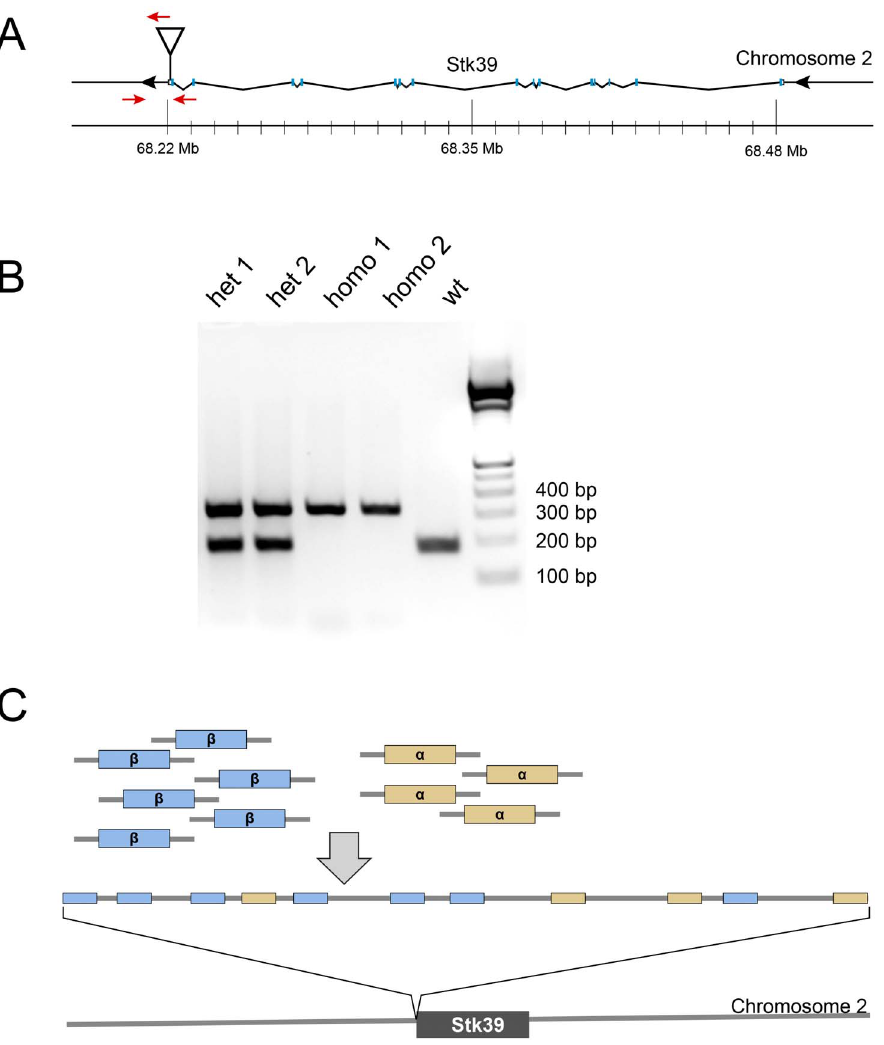
Figure 4. PCR analysis distinguishes the homozygosity or heterozygosity of pmel-1 transgene. ( A ) Diagram of PCR primers designed from the predicted pmel-1 TCR b transgene insertion site on chromosome 2. ( B ) PCR results of pmel-1 homozygous or heterozygous animals. ( C ) Conceptual model of tandem integration of the pmel-1 a and b chains in the genome.